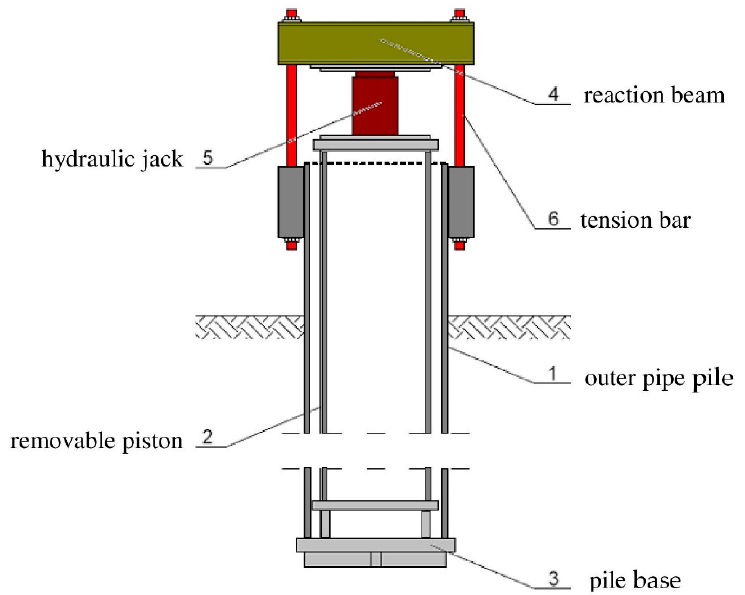
Figure 5. The idea of the innovative self-balanced pile testing method.